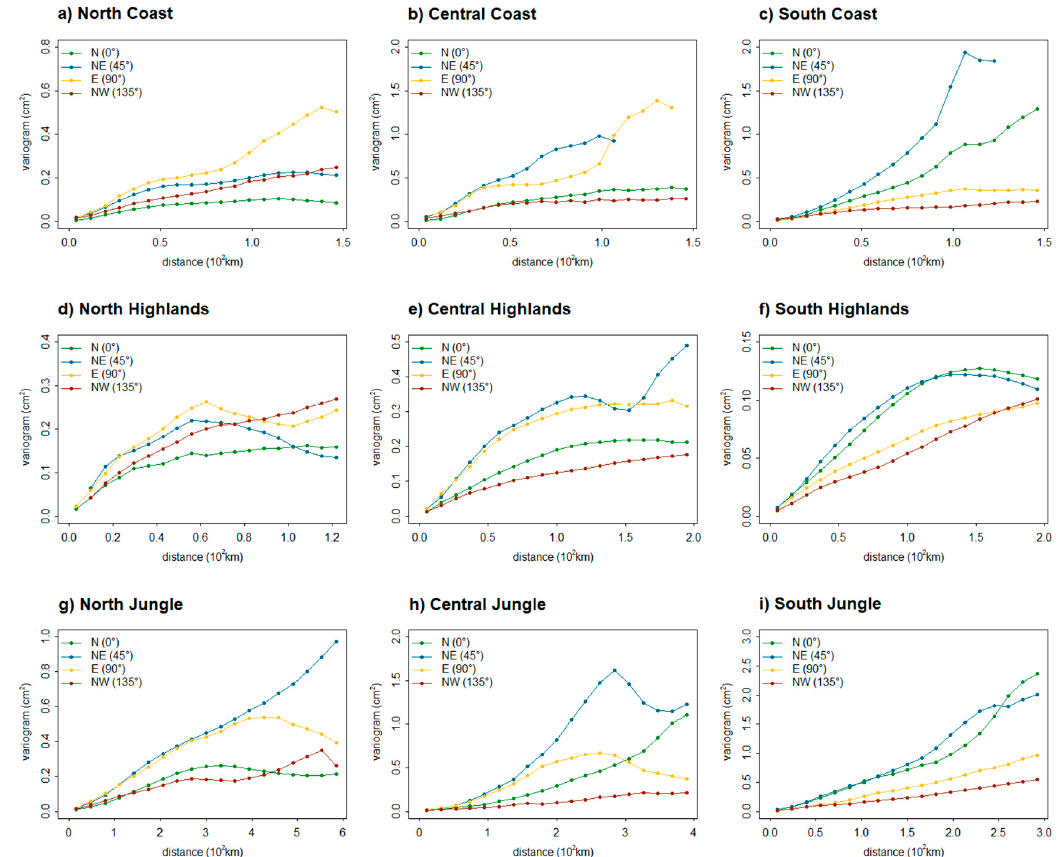
Figure 2. Directional variograms for the different sub-regions of the study area for the DJF season: ( a – c ) for the Coast region, ( d – f ) for the Highlands region, and ( g – i ) for the Jungle region. Values obtained from the MODIS PWV product.